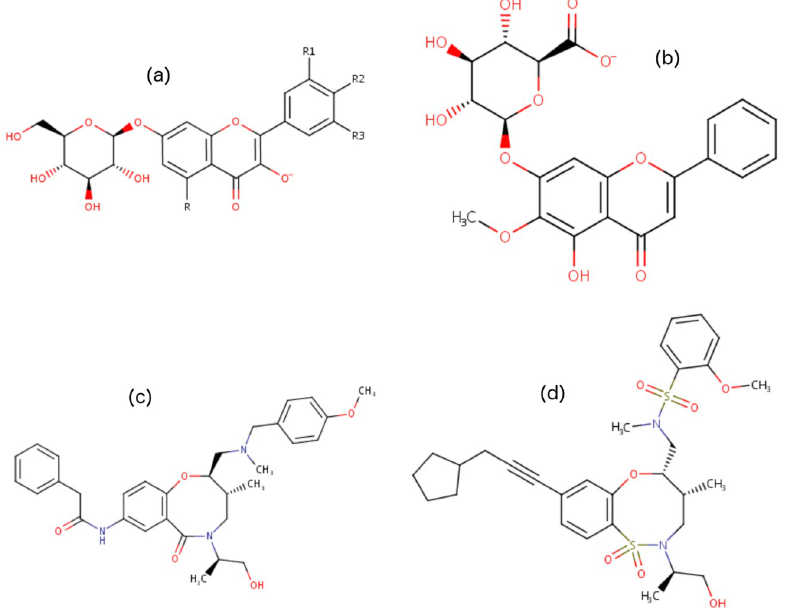
Fig 7. Two molecules of acid-onion family and two molecules of amid family. Molecule (a) and molecule (b) have a Tanimoto Coefficient equals to 0.25 and a similarity value with graph of cycles equals to 1.0. Molecule (c) and molecule (d) have a Tanimoto Coefficient equals to 0.27 and a similarity value with graph of cycles equals to 1.0. (a)oroxylin A 7-O- β -D-glucuronate(b)flavonolate 7-O- β -D-glucoside (c) N-[(2R,3R)-5-[(2R)-1-hydroxypropan-2-yl]-2- [[(4-methoxyphenyl)methyl-methylamino]methyl]-3-methyl-6-oxo-3,4-dihydro-2H-1,5-benzoxazocin-8-yl]- 2-phenylacetamide (d) N-[[(4R,5S)-8-(3-cyclopentylprop-1-ynyl)-2-[(2R)-1-hydroxypropan-2-yl]-4-methyl- 1,1-dioxo-4,5-dihydro-3H-6,1$l{6},2-benzoxathiazocin-5-yl]methyl]-2-methoxy-N-methylbenzenesulfonamide.